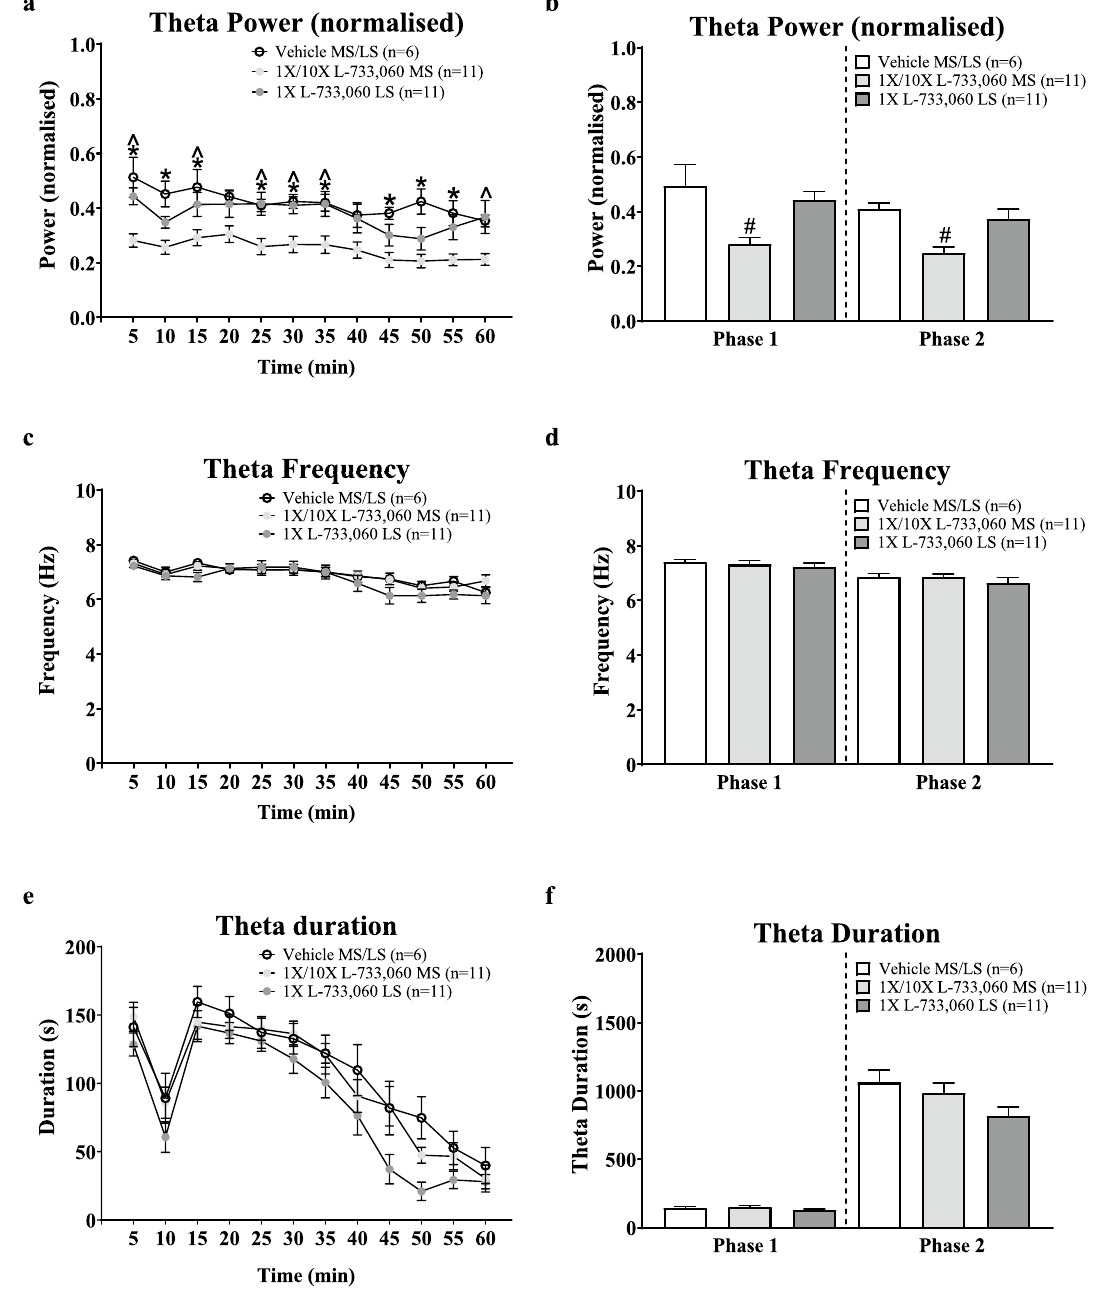
Figure 7. Microinjection of L-733,060 into the MS attenuated formalin-induced theta activity. Hippocampal theta activity was concomitantly recorded with formalin induced behaviour. Artifact free hippocampal theta segments of at least 2 s duration were analysed using Fast Fourier Transform (FFT; 0.5 Hz resolution) to quantify FFT theta peak frequency and power in 5 min blocks. FFT Theta peak power was normalised against the average FFT theta peak power of spontaneous theta activity recorded prior to the experiment. The duration of theta (s) reflects the cumulative duration of theta segments of at least 1 s length in blocks of 5 min. ( a , c , e ) Time course of change in theta parameters. ( b , d , f ) Histograms of the average normalised FFT theta peak power and FFT theta peak frequency, and cumulative theta duration in phases 1 and 2 of the formalin test. Administration of L-733,060 in the MS, but not LS, attenuated theta power. The drug did not evoke a significant change in FFT theta peak frequency and theta duration. Data are mean ± S.E.M. Significant difference (p < 0.05): ( a ) *‘1 ×/10 × L-733,060 MS’ group vs. ‘Vehicle MS/LS’ group and ^‘1 ×/10 × L-733,060 MS’ group vs. ‘1 × L-733,060 LS’ group; two-way RM ANOVA followed by Bonferroni post-hoc test, ( b ) # vs. ‘Vehicle MS/LS’